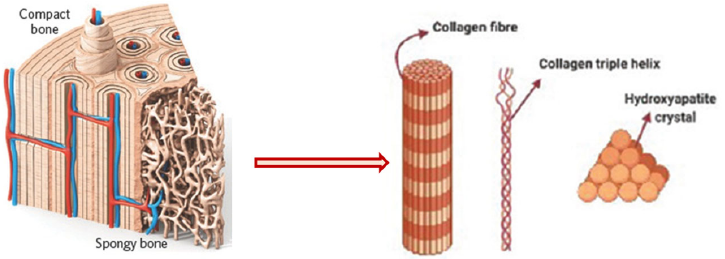
Figure 1. Schematic diagram of bone hierarchical structure. Reprinted with permission from Ref.